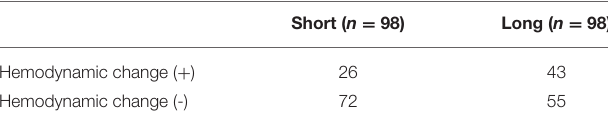
TABLE 3 | Correlation between hemodynamic changes and branch stent extension length.